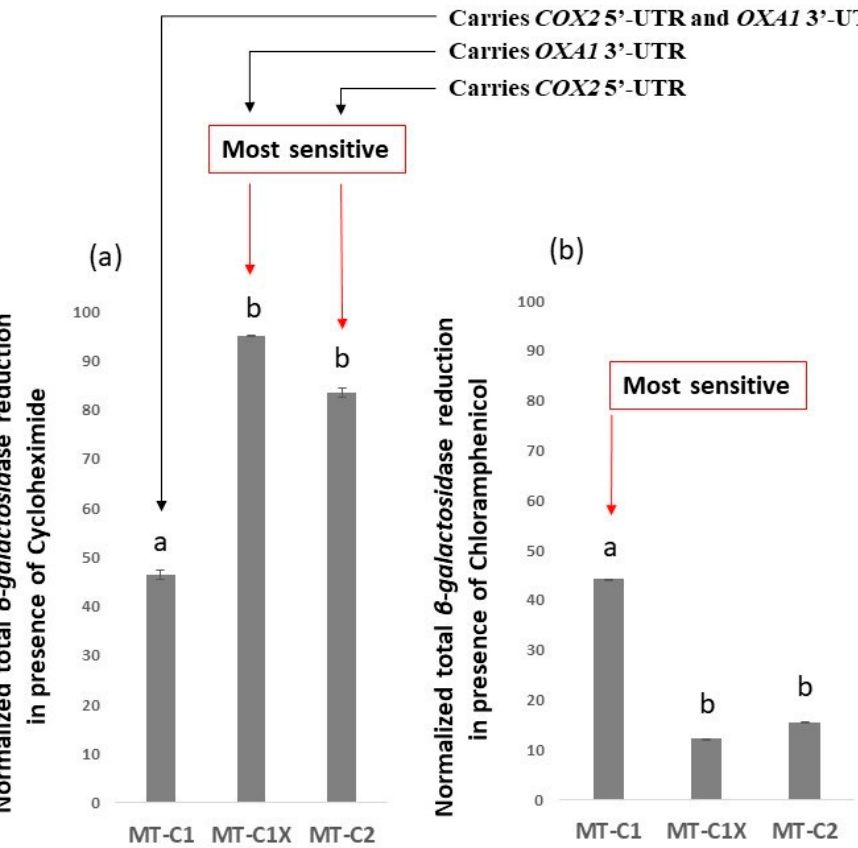
Figure 4. ( a ) In the presence of 45 ng/mL of cycloheximide, a cytoplasmic translation inhibitor, β -galactosidase, mediated by MT-C1X and MT-C2 showed the most sensitivity. ( b ) In contrast, when 1.4 mg/mL of chloramphenicol, a prokaryotic translation inhibitor, was added, β -galactosidase activity mediated by MT-C1 showed the most sensitivity. The values in ( a ) are related to the value of MT-C1 and values in ( a , b ) are normalized to the translation of the same construct in the absence of the corresponding translation inhibitory compound. Each experiment is repeated at least 3 times. Error bars represent standard deviation. a and b, represent statistically different values. One-way ANOVA ( p -value ≤ 0.05) was used to compare the di ff erences.